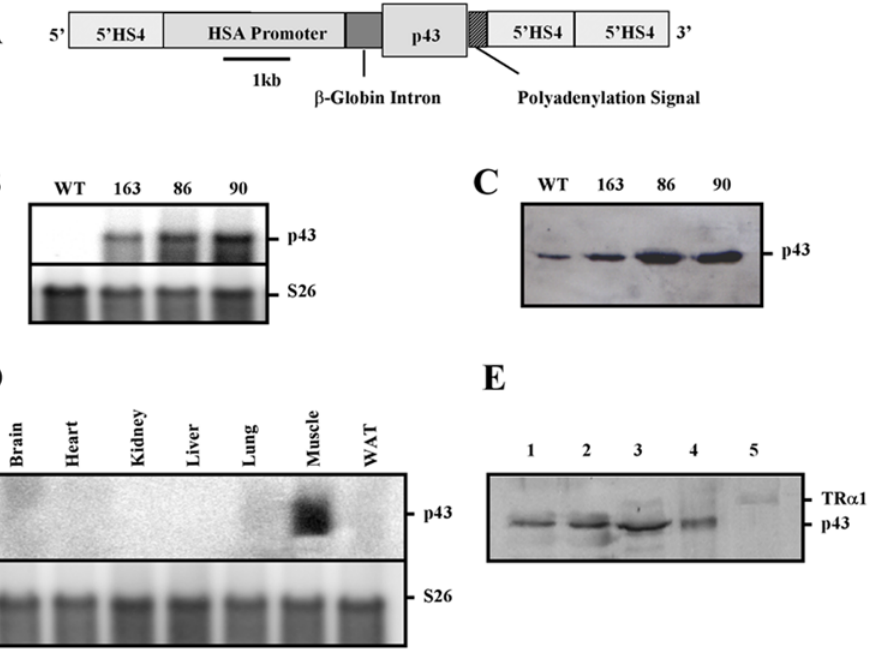
Figure 1. Transgenic expression of p43 in mouse skeletal muscle. (A) Schematic representation of the construct used for microinjection of [C57BL/6 x CBA] F1 fertilized oocytes. HSA: human a -skeletal actin; 5 9 HS4: chicken b -globin insulator. (B) mRNAs were isolated from quadriceps from transgenic mice of the 86, 90 and 163 lines versus wild-type (WT) animals and subjected to hybridization analysis with probes for p43. Hybridization with ribosomal S26 probes served as loading control. 20 m g of total RNAs were analyzed. (C) p43 protein levels in quadriceps muscle mitochondria from transgenic mice of the 86, 90 and 163 lines versus wild-type animals, visualized by western-blot using an antibody raised against TR a . 50 m g of mitochondrial proteins were analyzed. (D) mRNAs were isolated from various tissues from transgenic mice of the 86, 90 and 163 lines versus wild-type animals and subjected to hybridization analysis with probes for p43. Hybridization with ribosomal S26 probes served as loading control. 20 m g of total RNAs were analyzed. (E) Western blot of the fractions collected during the nuclear isolation using an antibody raised against TR a . Fractions are whole muscle homogenate-I (1), whole muscle homogenate-II (2), crude nuclear fraction (3), plasma membranes, mitochondria (4), nuclei (5). 25 m g of proteins were analyzed. Arrows indicate the nuclear receptor TR a 1 and